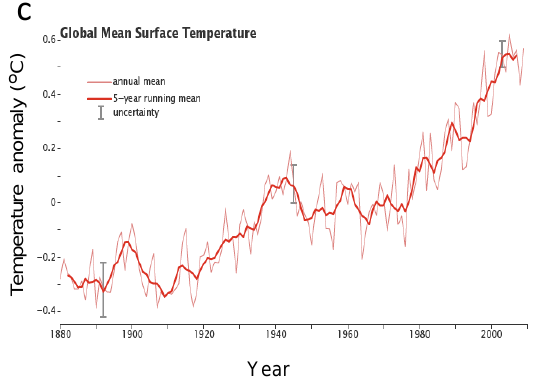
Figure 1. Trends in research output on global warming and past change in global mean surface temperature. ( a ) Absolute research output measured as number of publications on global warming published per year up to December 2015. Figure is based on data extracted from a topic search for “climate change” or “global warming” conducted 27 October 2016, from ISI Web of Science. The literature search yielded 141,501 papers, pooled across scientific disciplines, published between 1974 and December 2015 (indicated in red). Of these, 5740 studies concerned global warming and climate change within marine and freshwater environments (indicated in blue); ( b ) Relative research output on global warming expressed as percentage of total research output summed across all scientific disciplines; ( c ) Global warming as indicated by the rapid increase in Earth’s average surface temperature over the past century (obtained from NASA’s Earth Observatory [19]).